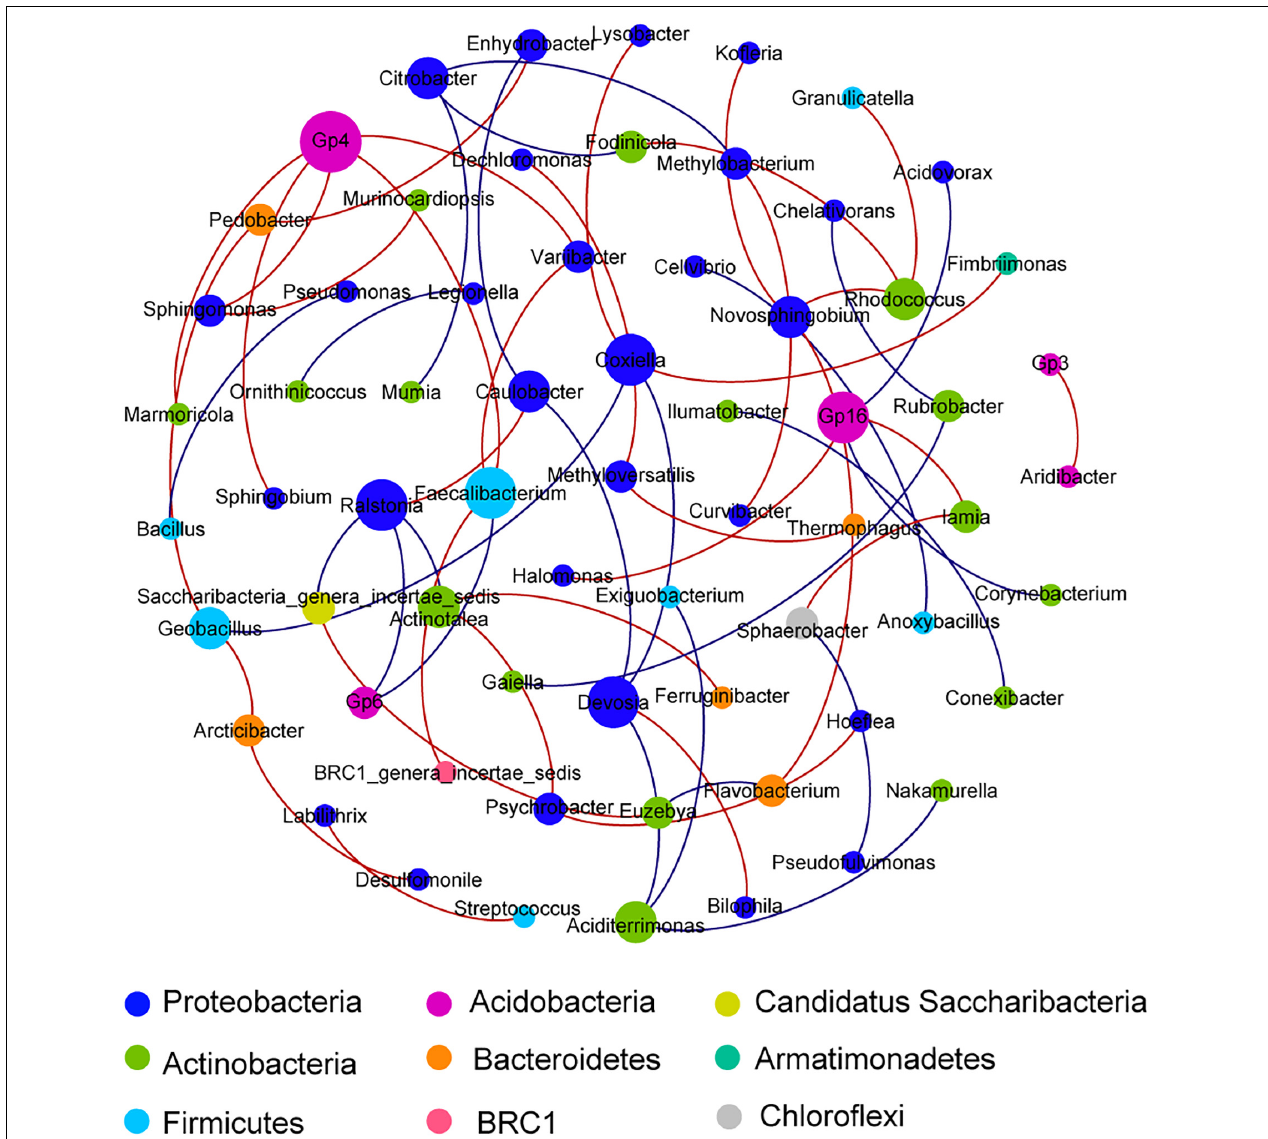
FIGURE 4 | A network of co-occurrence pattern at genus level from all samples. Each line represents a significant correlation between two nodes; the red lines represent positive correlations, while the blue lines represent negative correlations. The size of each node is proportional to the number of connections. Correlations were identified by SparCC’s coefficient > 0.65 or < − 0.65 and P < 0.01, with each node representing a bacterial genus and the color representing the phylum that the genus is affiliated